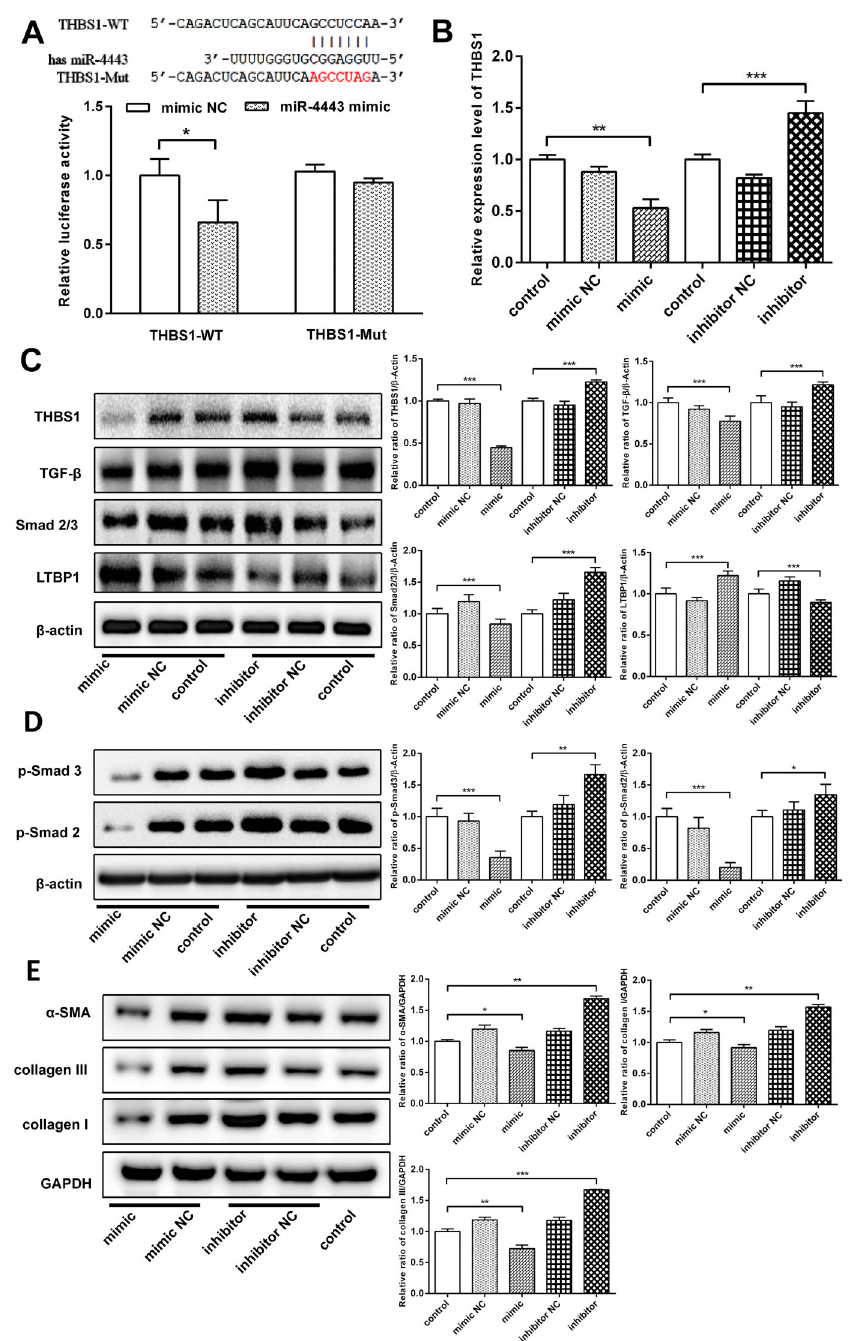
Figure 3. hsa-miR-4443 targeted THBS1 to regulate transforming growth factor (TGF)- b 1/ a -SMA/collagen signaling in human cardiac fi broblast (HCFBs). A , Binding sequences between hsa-miR-4443 and THBS1 3 0 -UTR transcripts, and dual-luciferase activity assay revealed hsa-miR-4443 targeted THBS1. B , hsa-miR-4443 promoted THBS1 mRNA degradation. C , The expression of THBS1, TGF- b , Smad2/3, and LTBP1 protein was examined in HCFBs. D , p-Smad2 and p-Smad3 expression levels were detected. E , a -SMA, collagen I, and collagen III protein expression levels were compared with the control group. All data are reported as means ± SD of at least three independent experiments. *P o 0.05, **P o 0.01, and ***P o 0.001 vs control (Student ’ s t -test or one-way ANOVA analysis with two-sided LSD post hoc test). NC: negative